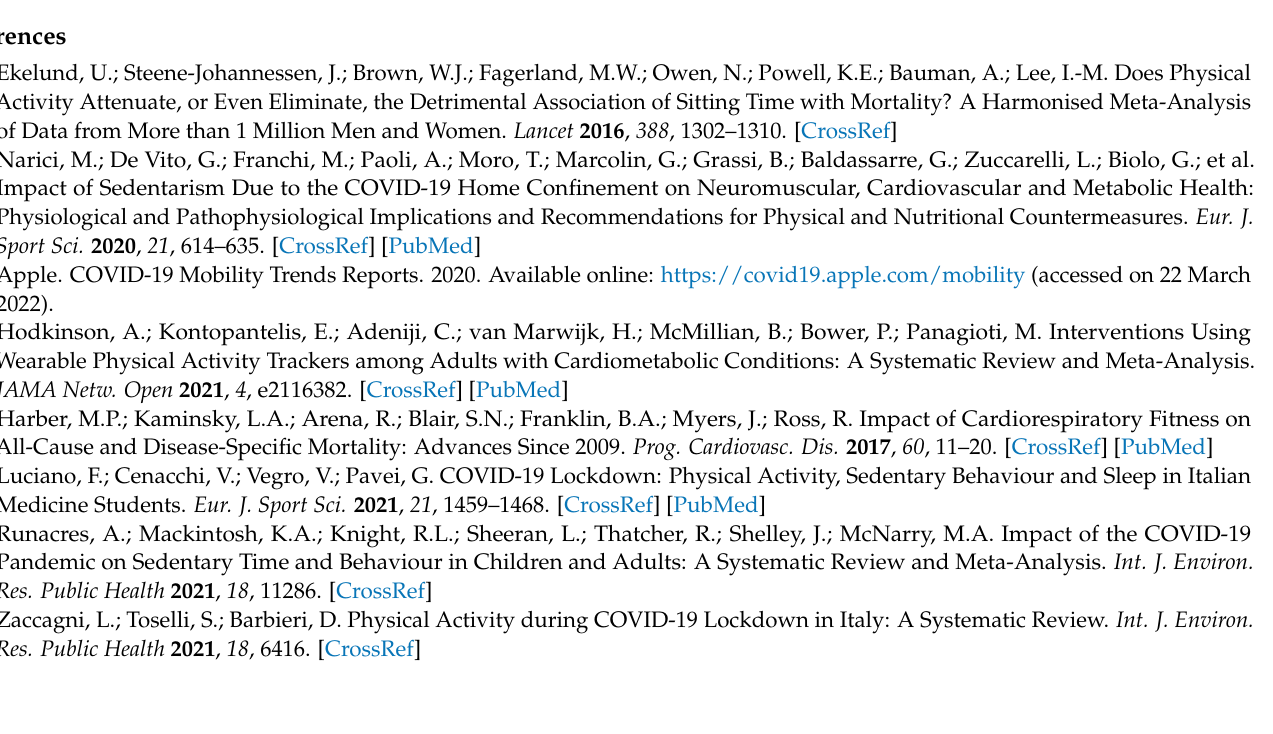
for physical activity, Table S3: Descriptive statistics for sedentary behaviour, Table S4: